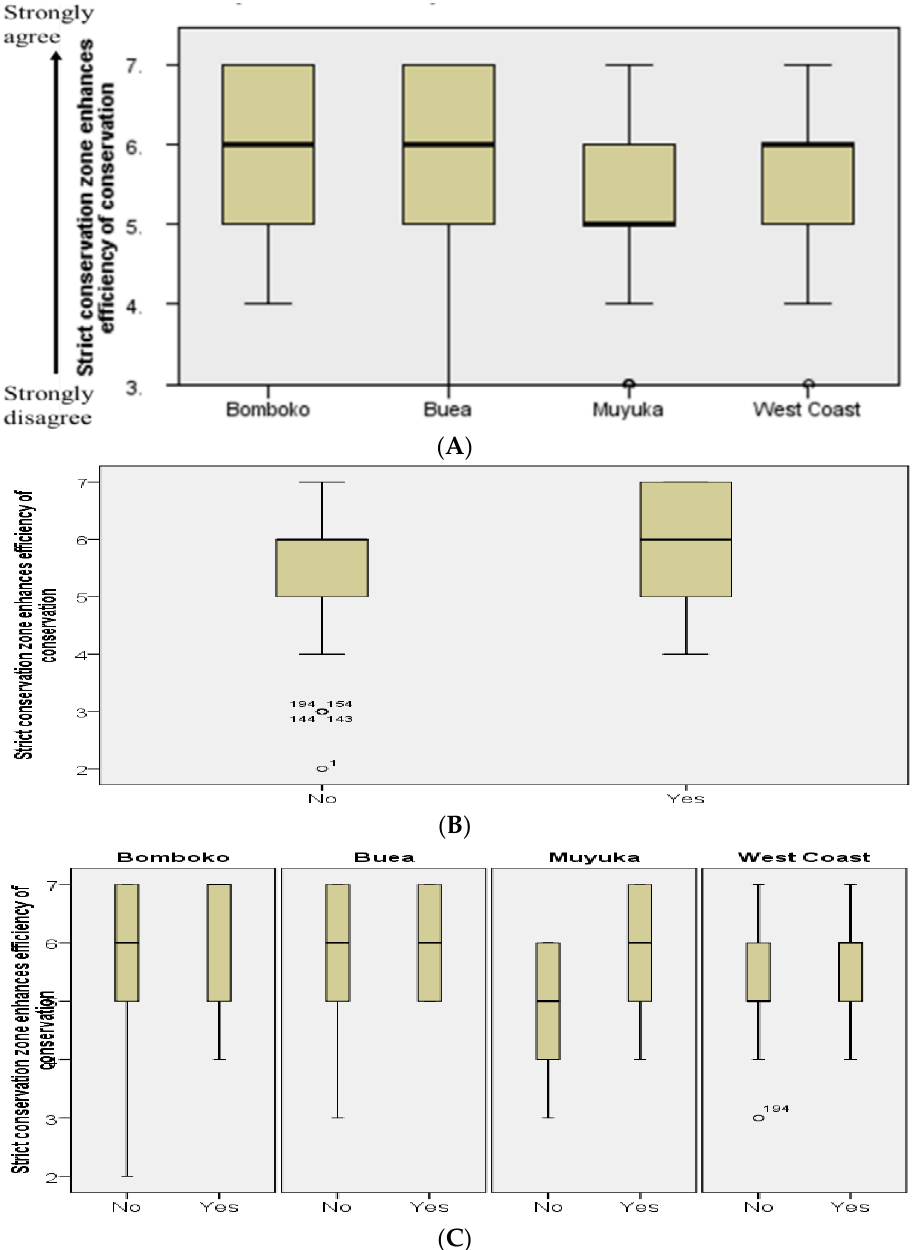
Figure 4. Kruskal–Wallis plot showing the variance of perception of a strict zone between clusters ( A ), and t -test plots showing how the perception of a strict conservation zone influences participation in MCNP activities in all clusters ( B ) and within each cluster ( C ).